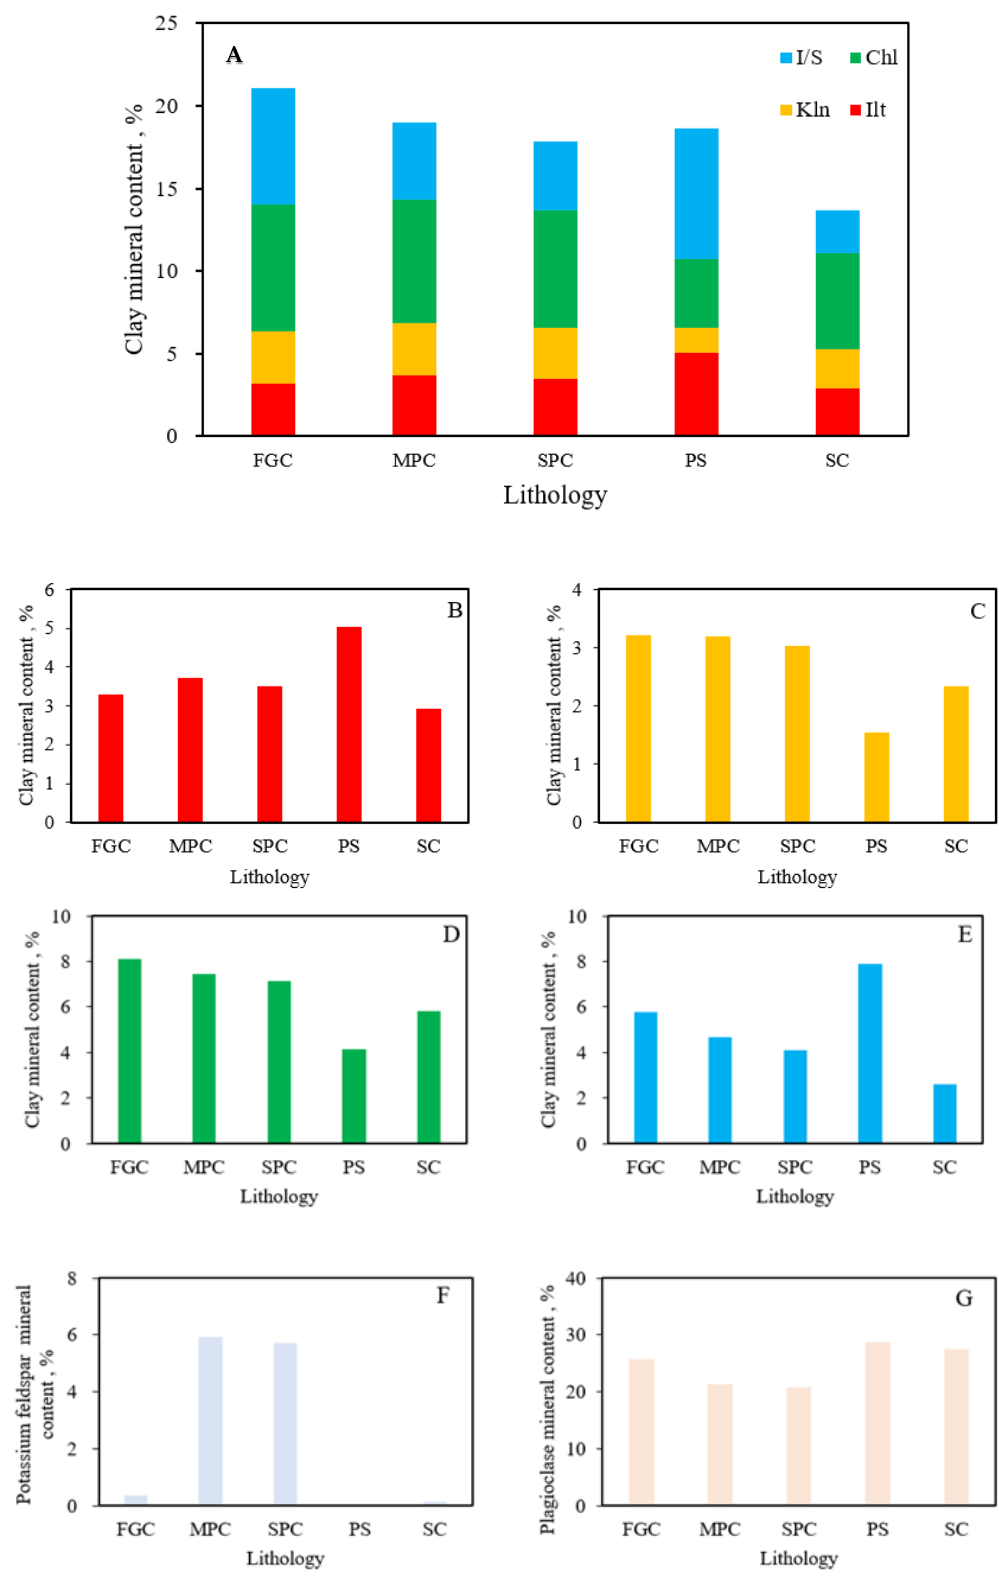
Figure 9. Relationships between lithology and mineral contents in the Mahu area: ( A ) Total clay minerals; ( B ) Illite; ( C ) Kaolinite; ( D ) Chlorite; ( E ) Illite/smectite; ( F ) Potassium feldspar; and ( G ) Plagioclase. Note: FGC: fine-grained conglomerate; MPC: conglomerate with medium pebbles; SPC: conglomerate with small pebbles; PS: pebbly sandstone; SC: sandy conglomerate. The clay minerals mainly fill the intergranular pores and secondary pores, leading to plugging of the primary intergranular pores and secondary pores and a decrease in the permeability. The negative correlation between the I/S content and the porosity is due to the hydration and expansion of the I/S when it encounters water and the phenomenon of particle migration (Figure 8). In addition, the filling of the pores with I/S occupies the reservoir space and destroys the pore structure, so the I/S content is negatively correlated with the porosity. The crystal shape of the kaolinite is relatively stable, so it can retain intergranular pores well, and some dissolution pores form during its generation. Inter- granular pores and dissolution pores are important contributors to the reservoir space, so the kaolinite content is positively correlated with the porosity. Several scholars have stud- ied the occurrence state of chlorite in the Baikouquan Formation reservoir in the Mahu Depression [26,43]. Their results show that chlorite exists in the form of chlorite film in the early stage and granular chlorite directly fills the pores in the late stage. The chlorite film is generally formed before the compaction stage, which inhibits the cementation of the quartz and thus protects the pore structure of the reservoir. However, the granular chlo- rite filling the pores occupies the original reservoir space and reduces the reservoir seep- age capacity. Due to the coexistence of these two forms of chlorite in the Mahu conglom- erate reservoir, there is no obvious correlation between the chlorite content and the po- rosity (Figure 10).